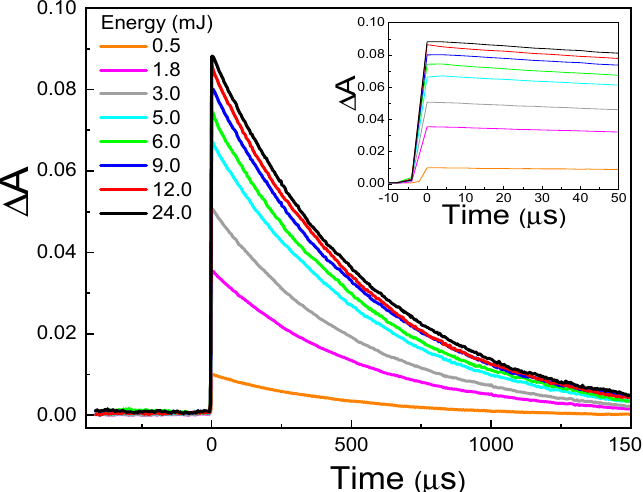
Figure 3. Decay kinetic curves of the TMPyP triplet state T 1 for different exciting pulse energies (probe wavelength at 470 nm).